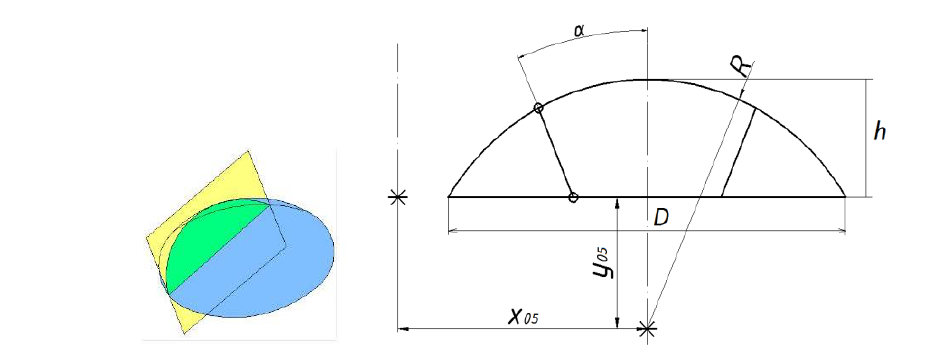
Fig. 9 . Geometric model of the bottom with petal